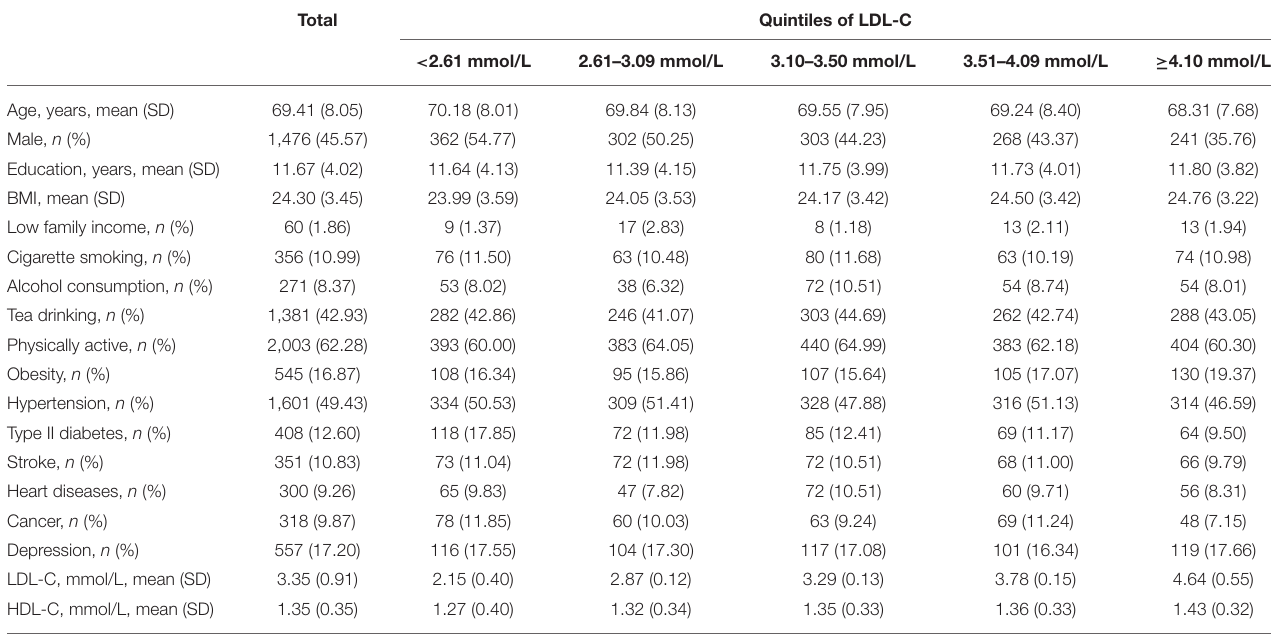
TABLE 1 | Baseline characteristics of study participants.